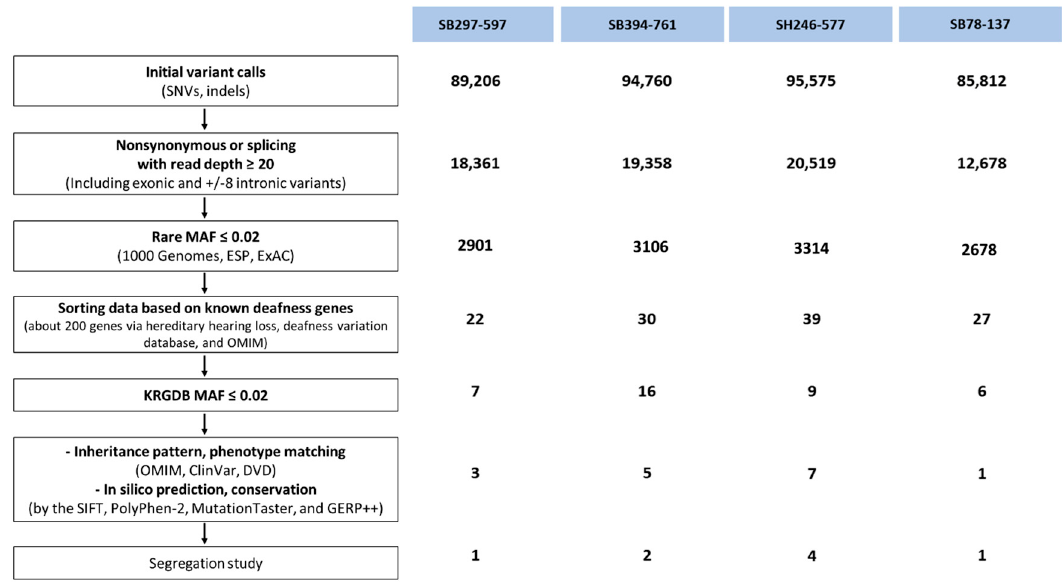
Figure 2. Variant filtering strategy of Exome sequencing data and the number of candidate variants in four unrelated families. Single-nucleotide variations, SNVs; MAF, minor allele frequency; Exome Aggregation Consortium databases; ESP, Exome Sequencing Project; ExAC, Exome Aggregation Consortium databases; KRGDB, Korean reference genomic database; OMIM, Online Mendelian